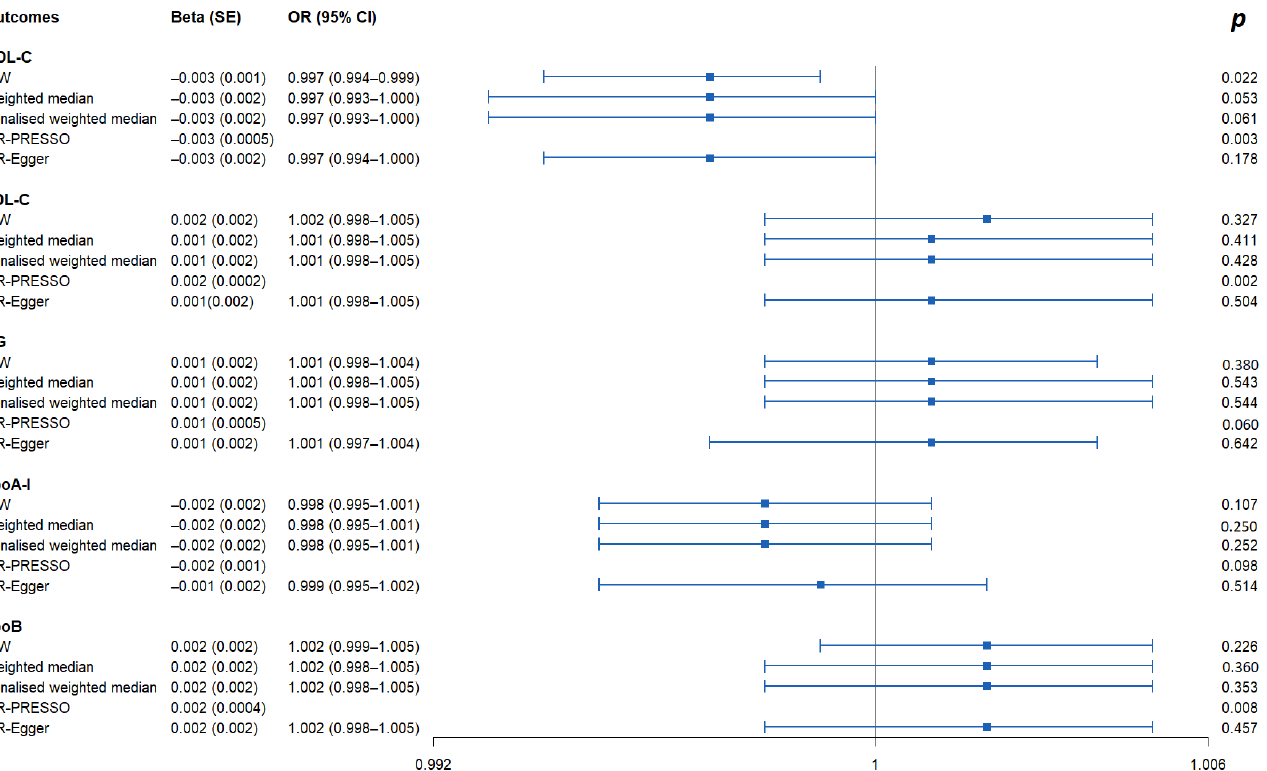
Figure 1. Causal effects of VaD on lipid-related traits via reverse MR analyses. IVs: instrumental variables; IVW: inverse-variance weighted; MR: Mendelian randomization; PRESSO: pleiotropy residual sum and outlier; OR: odds ratio; CI: confidence interval; HDL-C: high-density lipoprotein cholesterol; LDL-C: low-density lipoprotein cholesterol; TG: triglyceride; apoA-I: apolipoprotein A-I; apoB: apolipoprotein B.